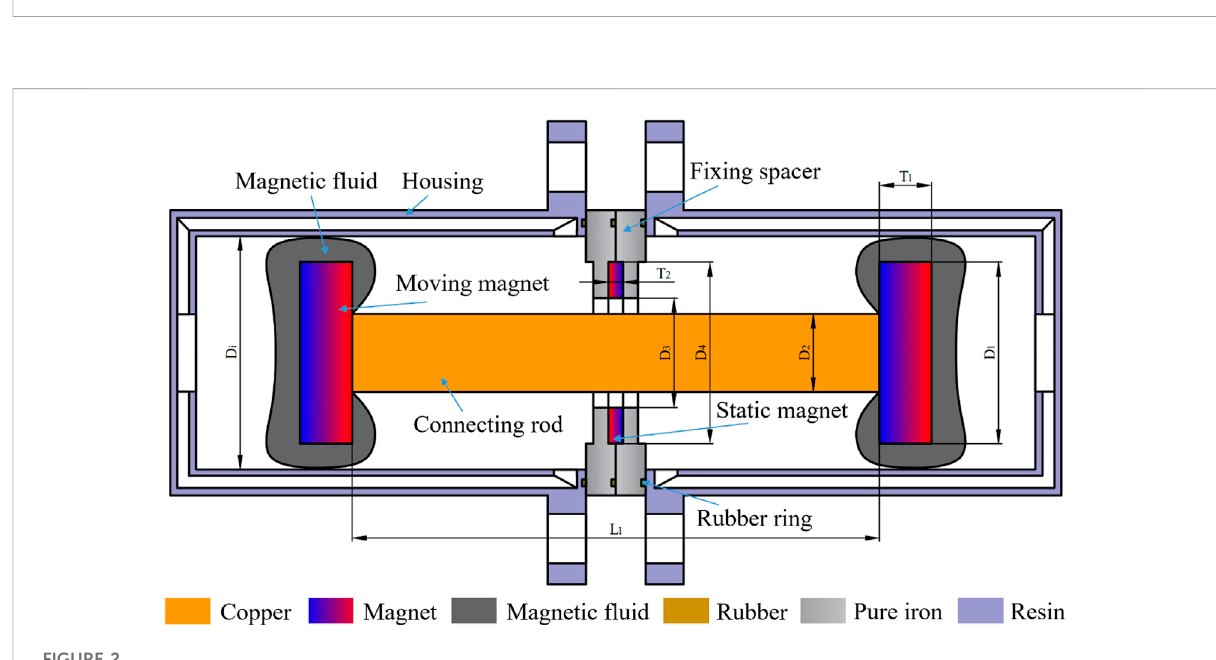
FIGURE 2 Section view of the varying stiffness magnetic fl uid shock